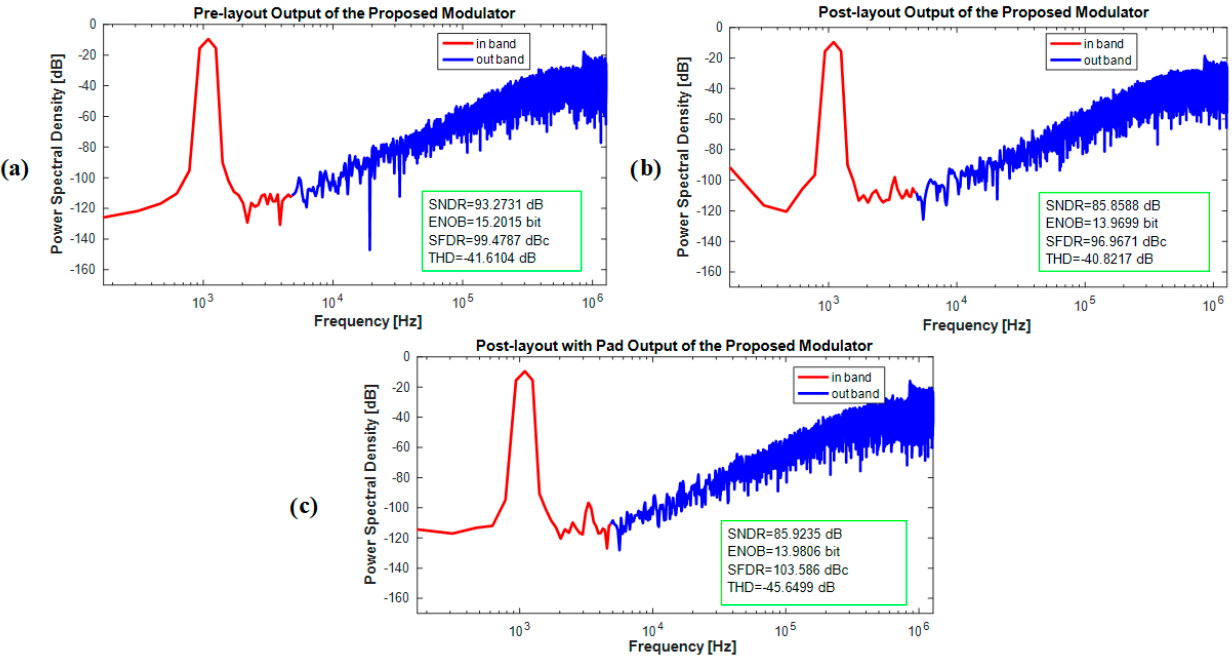
Figure 19. The ∆Σ modulator’s PSD, the effective number of bits (ENOB), and THD results: ( a ) pre- Figure 19. The ΔΣ modulator’s PSD, the e ff ective number of bits (ENOB), and THD results: ( a ) pre- layout, ( b ) post-layout, and ( c ) post-layout with pad. layout, ( b ) post-layout, and ( c ) post-layout with pad.